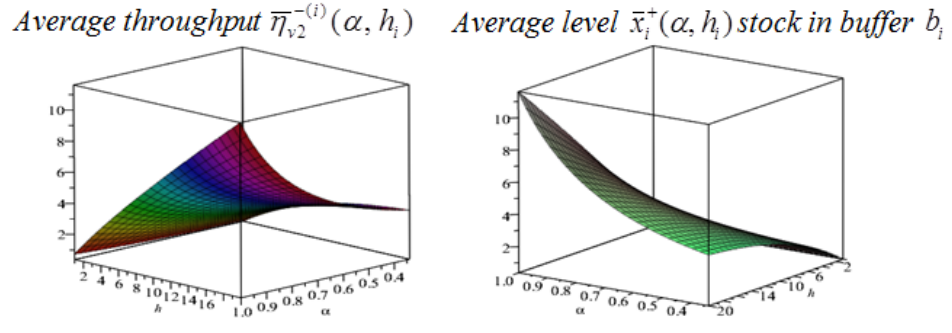
Figure 11 . The average throughput